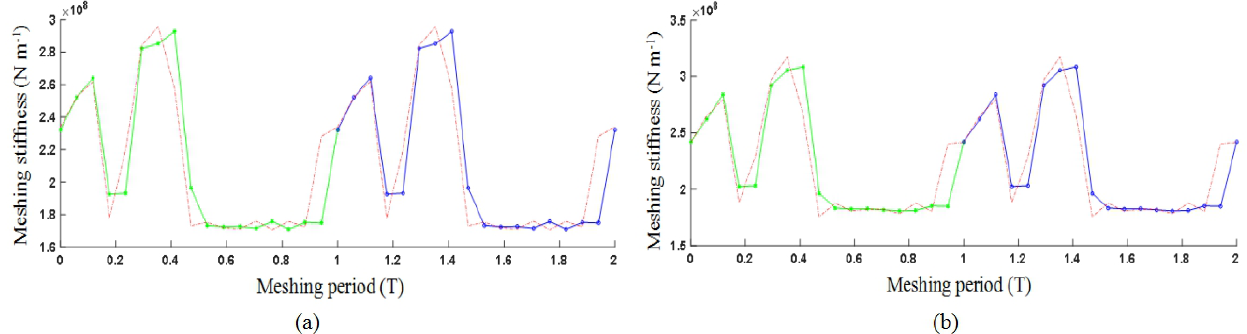
Figure 3. Fitting curve of time-varying meshing stiffness. (a) Meshing stiffness of the gear pair 1. (b) Meshing stiffness of the gear pair 2. Table 1. The parameter of bevel gears.